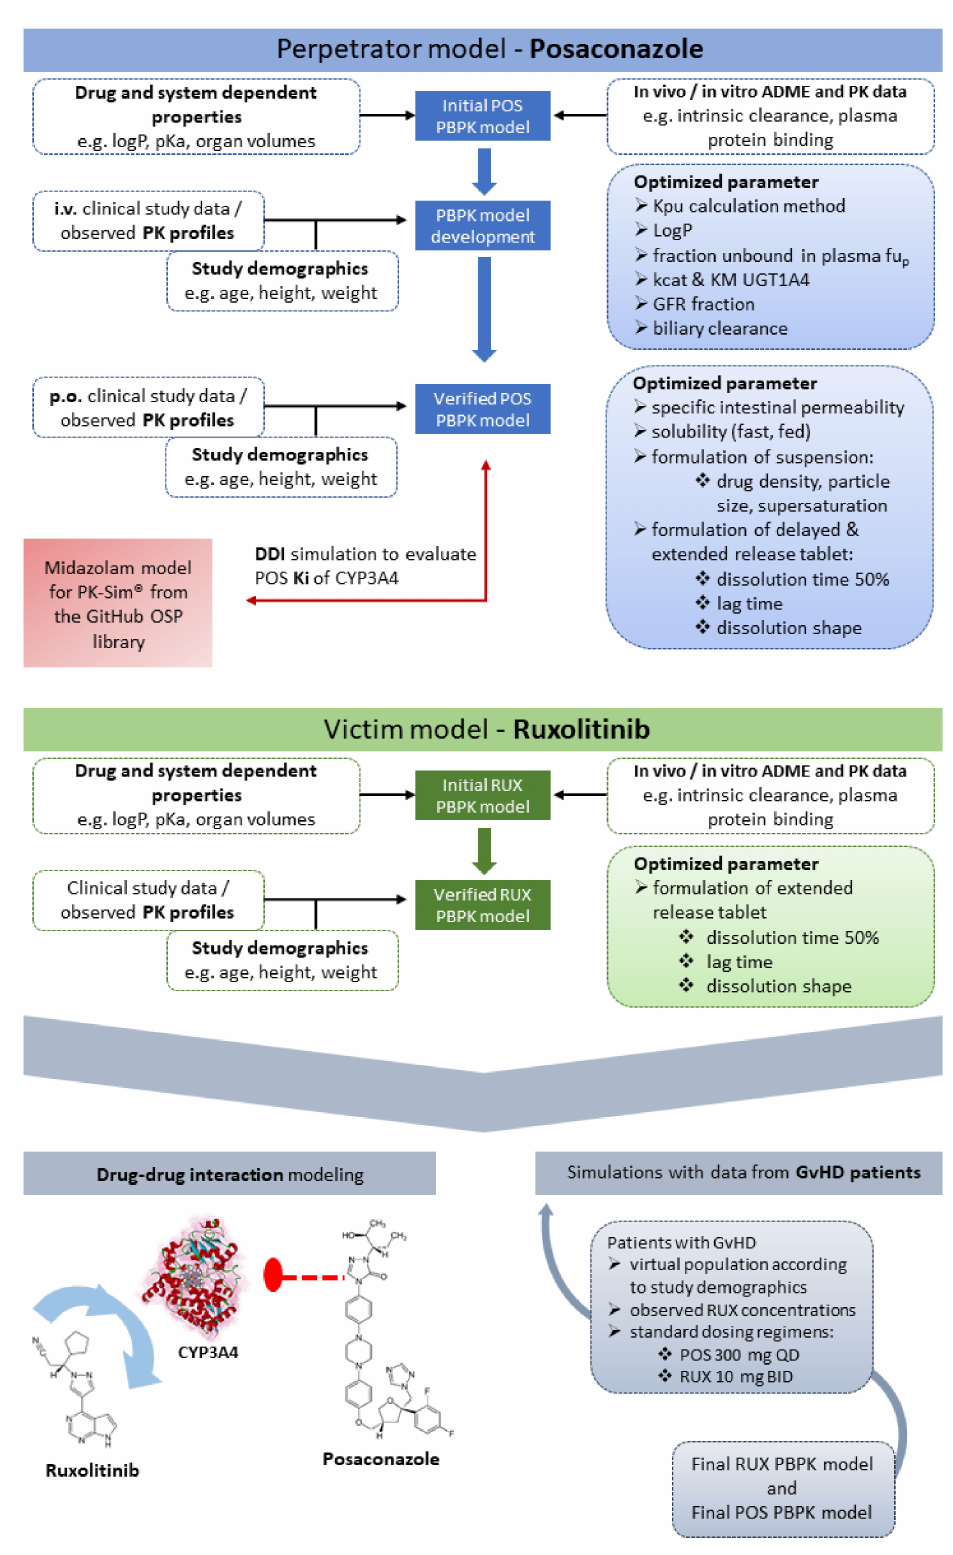
Figure 1. Schematic workflow showing the development and evaluation of the perpetrator (POS) and victim (RUX) PBPK models, which were developed separately. Initial model development started with basic input parameters from the literature. Parameters optimized during model building are